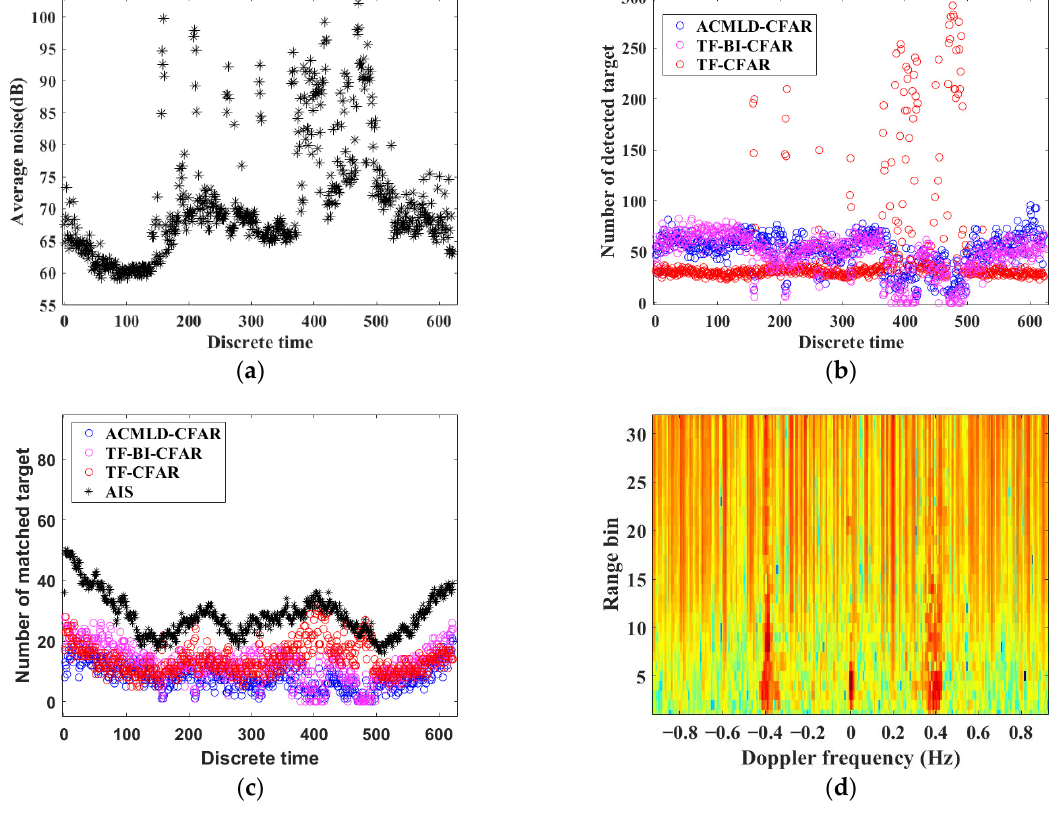
Figure 12. Target detection in the presence of strong interference. ( a ) time sequence of average noise intensity; ( b ) time sequence of the number of detected targets by ACMLD-CFAR, TF-BI-CFAR, and TF-CFAR; ( c ) time sequence of the number of matched targets by ACMLD-CFAR, TF-BI-CFAR, and TF-CFAR; ( d ) RD map contaminated by strong interference.